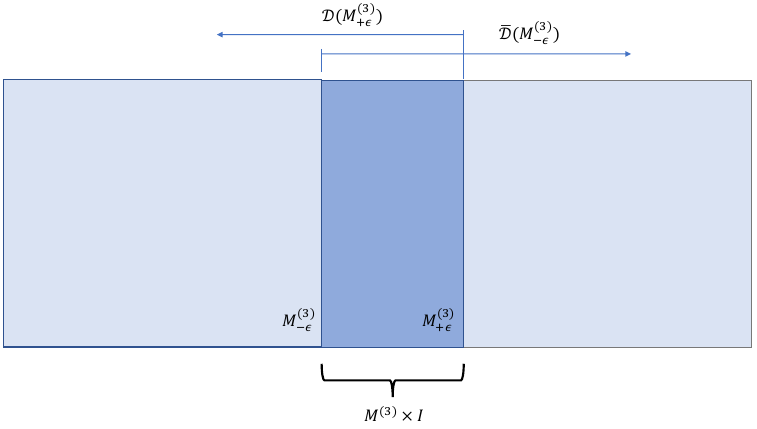
¯ D ( M (3) ) . We ) and ¯ D ( M (3) ) + ε − ε